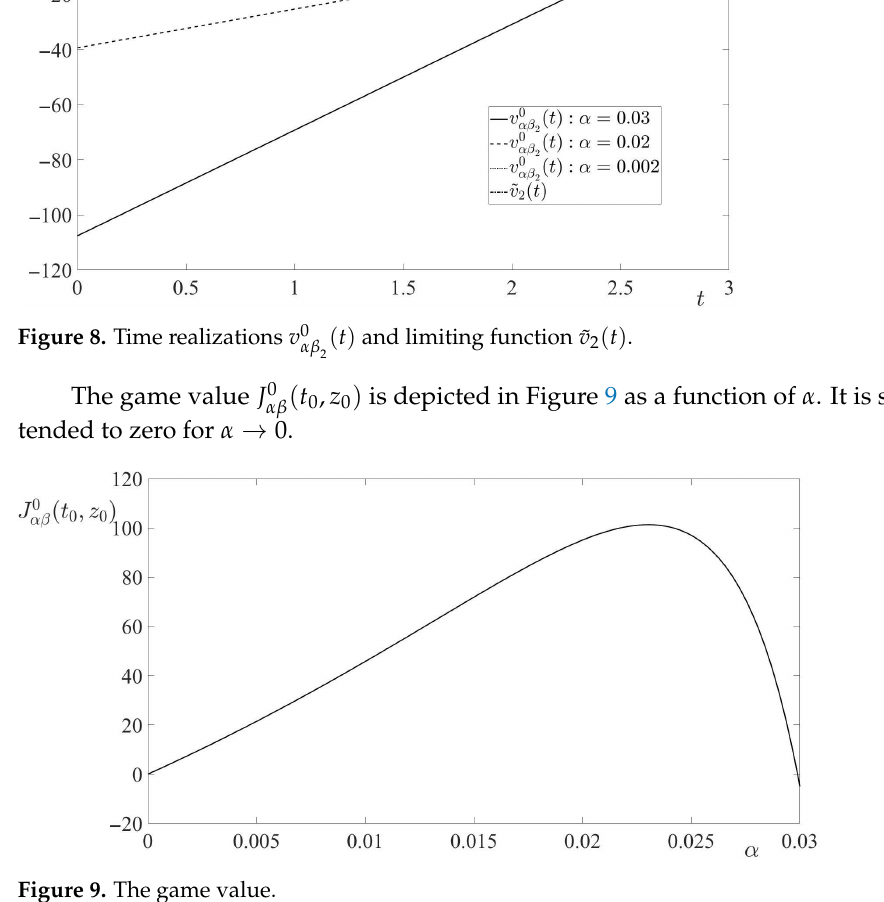
Figure 9. The game value. The respective terminal and integral terms of the cost function are shown in Figures 10 and 11, respectively. It is seen that all components of the optimal cost tended to zero for α → 0.